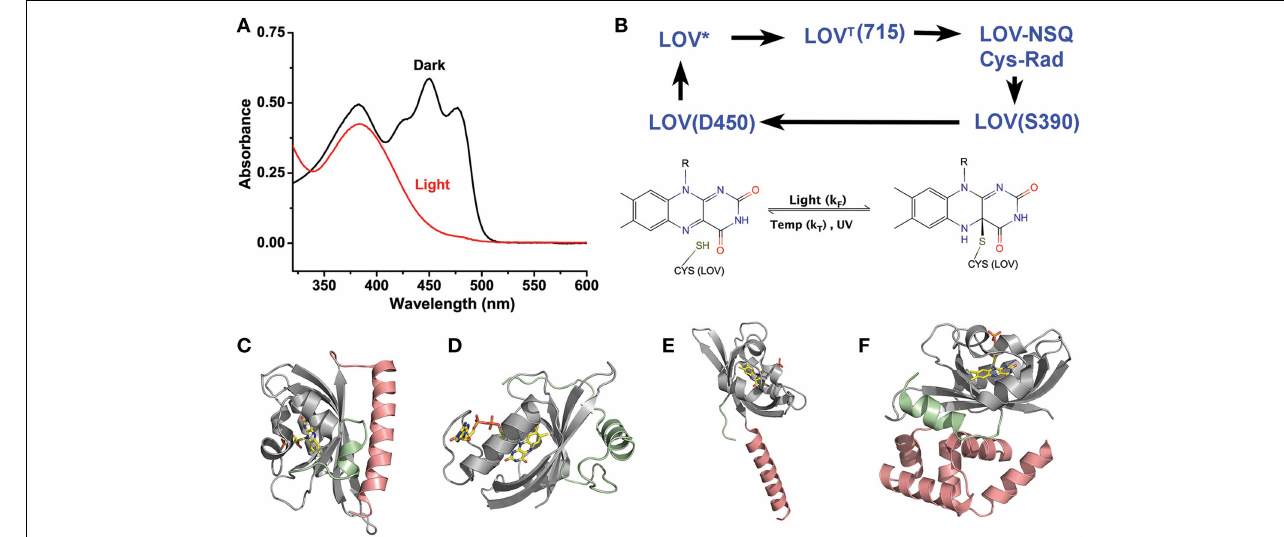
FIGURE 1 | LOV chemistry and structure. (A) Typical photocycle spectra of LOV containing proteins. Dark state proteins (black) demonstrate spectra consistent with oxidized flavin. Light activation (red) bleaches the 450nm absorbing bands leaving a single 390nm peak indicative of a C4a adduct. (B) LOV photocycles are characterized by a ground state oxidize flavin that form a flavin-cysteine C4a adduct following blue-light treatment. Adduct formation proceeds through an excited singlet state (LOV * ) that